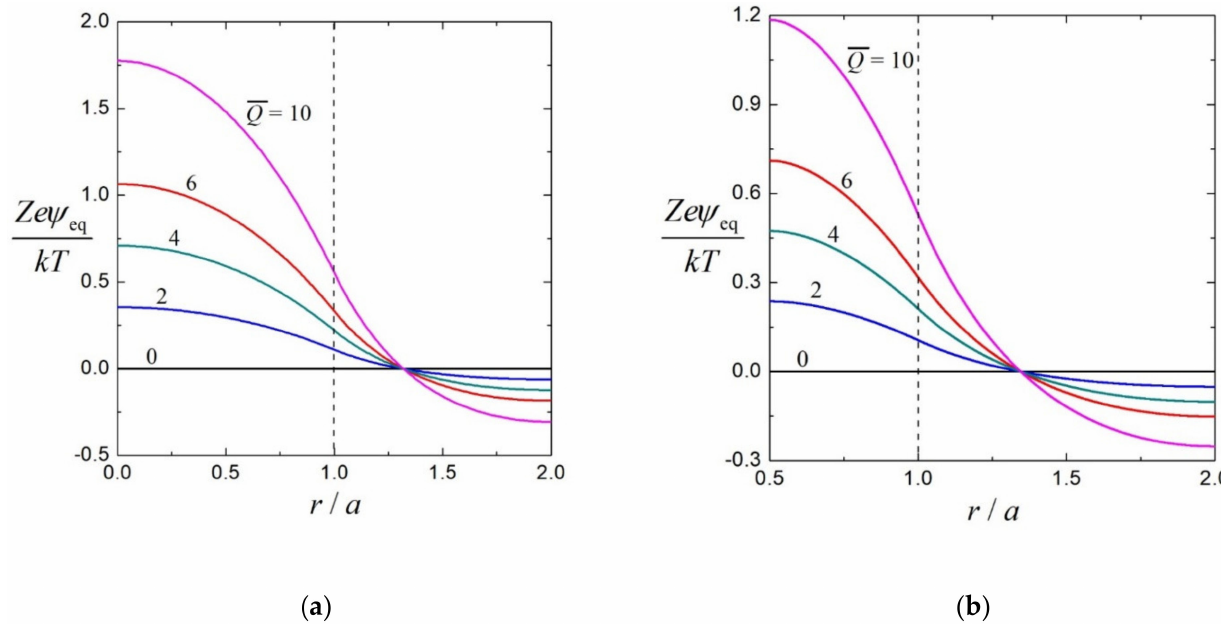
Figure 2. Dimensionless equilibrium electric potential Ze ψ eq / kT for a soft sphere in a unit cell of ϕ = 0.125 ( a / b = 0.5) versus the scaled coordinate r / a with Q as a parameter: ( a ) r 0 / a = 0 (porous sphere); ( b ) r 0 / a =